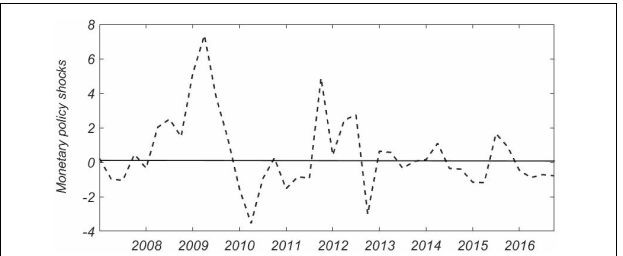
FIGURE 1 | The exogenous shock component of monetary